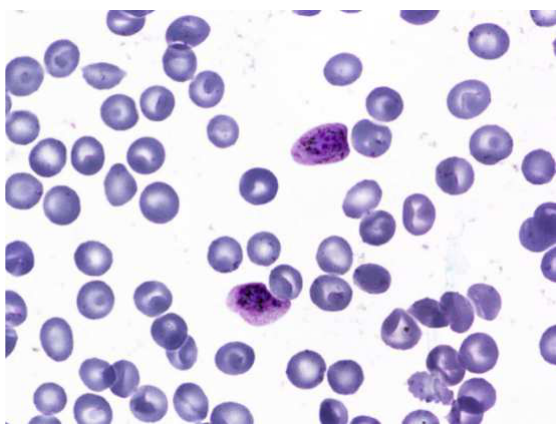
Figure 8. Sample image from the dataset.